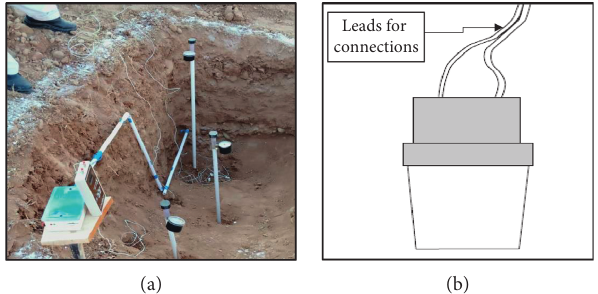
Figure 2: (a) Actual instrumentation in the field. (b) Electrical resistivity sensor used.